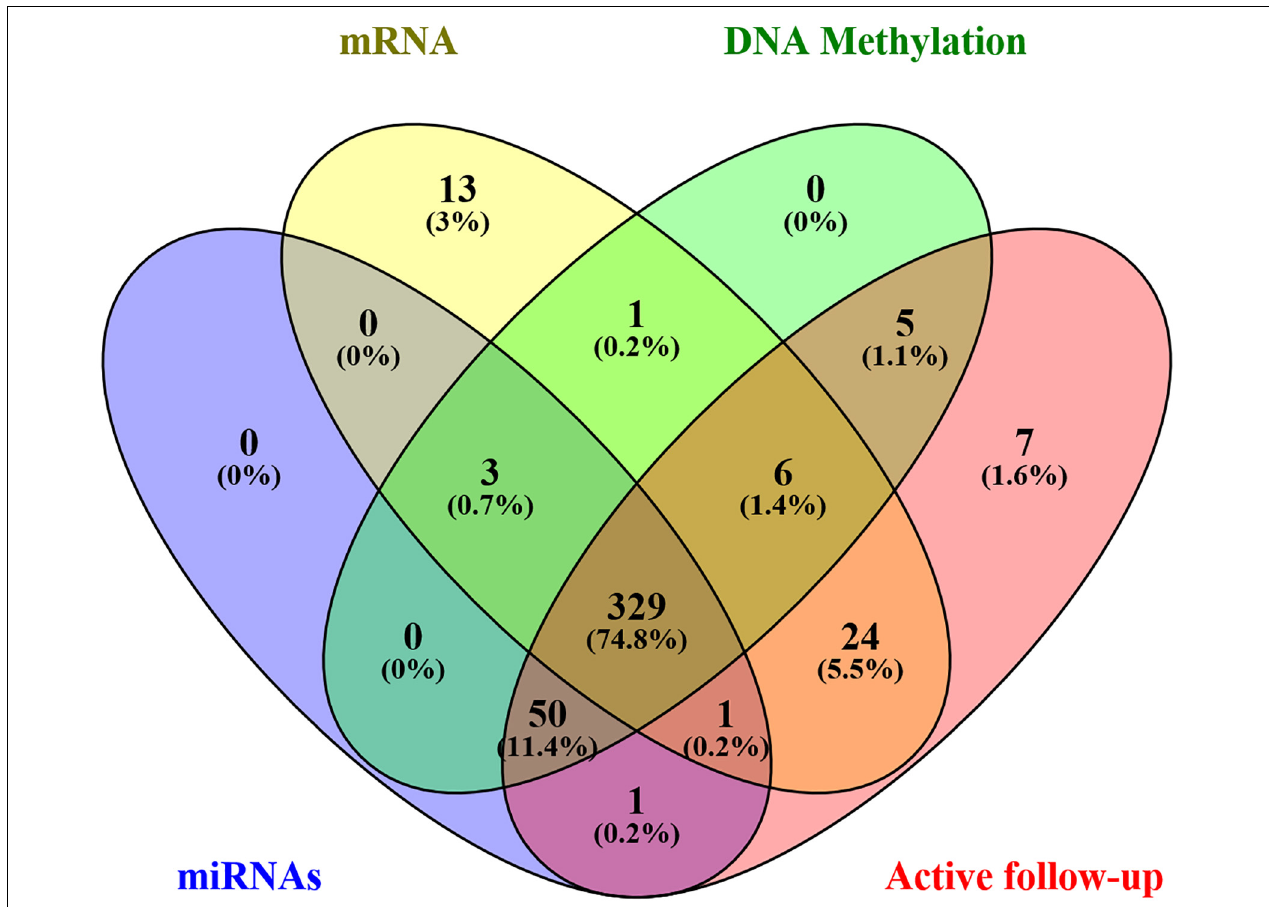
FIGURE 1 | A Venn diagram displays the patients’ screening